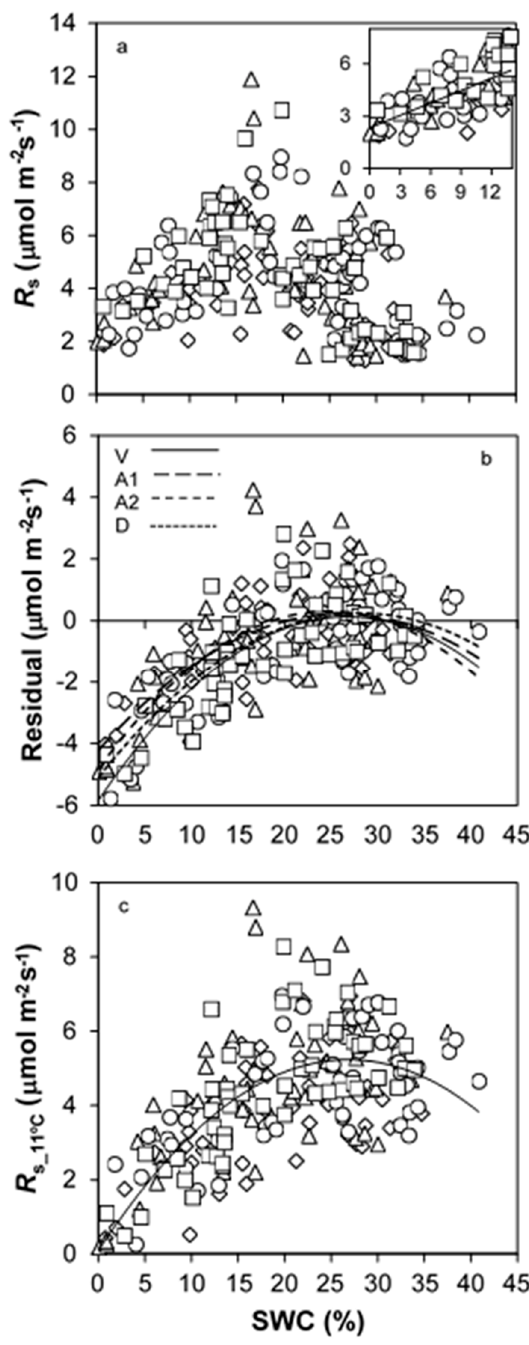
Figure 4. Observed soil respiration (R s ; a ) and derived parameters ( b, c ) modeled as a function of soil water content (SWC) in plots established around centennial beech trees of different decline classes – vigorous (V; squares), affected (A1; diamonds), severely affected (A2; triangles), and dead (D; circles). Data points are mean values per plot and sampling campaign. In ( a ) the inset depicts the relationship below 15% SWC. b, c ) relationship of SWC with residuals between observed R s values and R s values modeled from T s above 15% SWC ( b ), and standardized R s at 11 °C (mean annual T s ; c ). Non-linear regression models were fitted pooling all tree-decline classes or separately among tree-decline classes to account for the significant relationship of T s with factor “Decline” (see Table 2).